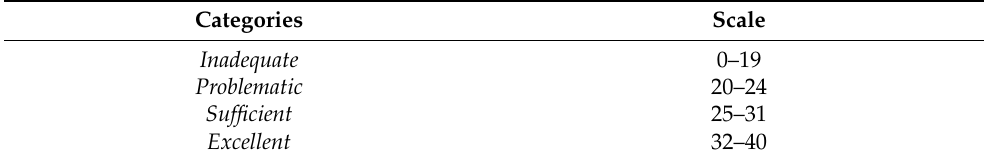
Table 1. Qualitative categories of eHealth literacy.